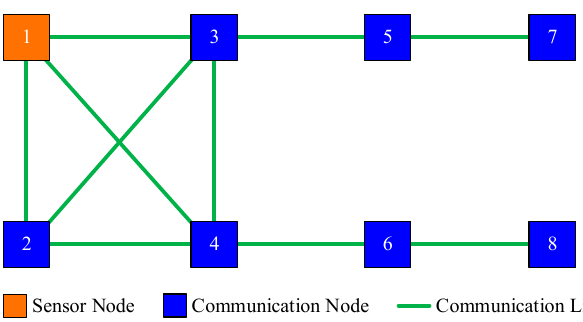
Figure 1. An illustrated sensor network with naive nodes.